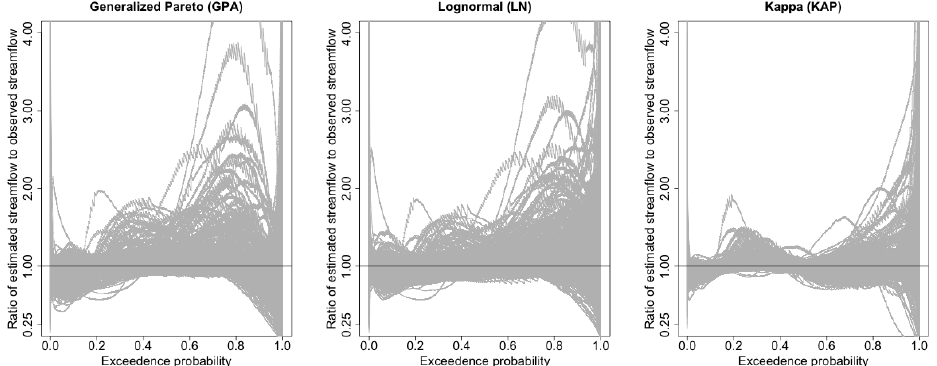
Figure 4. Error duration plots illustrating the range of errors (the ratio of predicted quantiles of flow to observed ranked flows) across exceedance probabilities for generalized Pareto, lognormal, and kappa hypotheses. Each grey line represents the estimated relative error for a study streamgage and the black horizontal line at one shows no error.